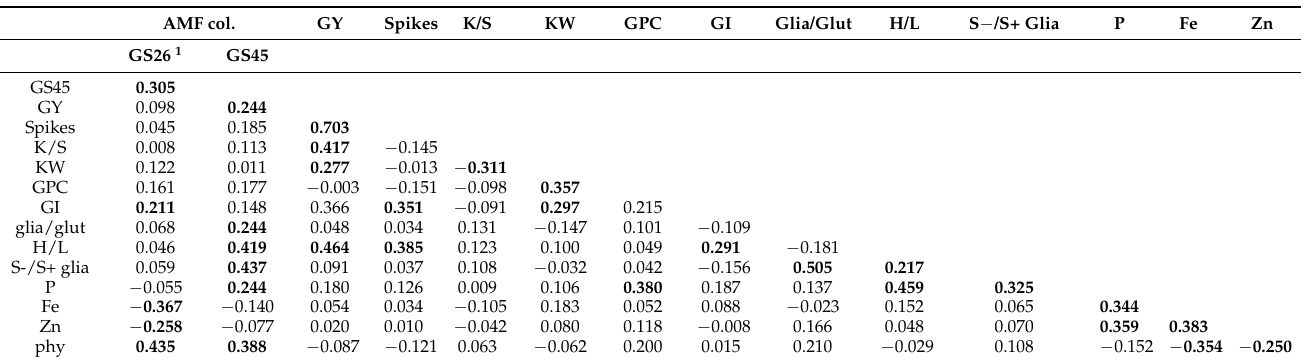
Table 3. Correlation values among AMF root colonization (AMF col.) at the end of tillering (G26) and at booting growth stages (GS45) and wheat agronomic and quality parameters. In bold are statistically significant P values according to the correlation of Pearson ®on square root transformed and standardized data (standardization based on the variables over the maximum value).